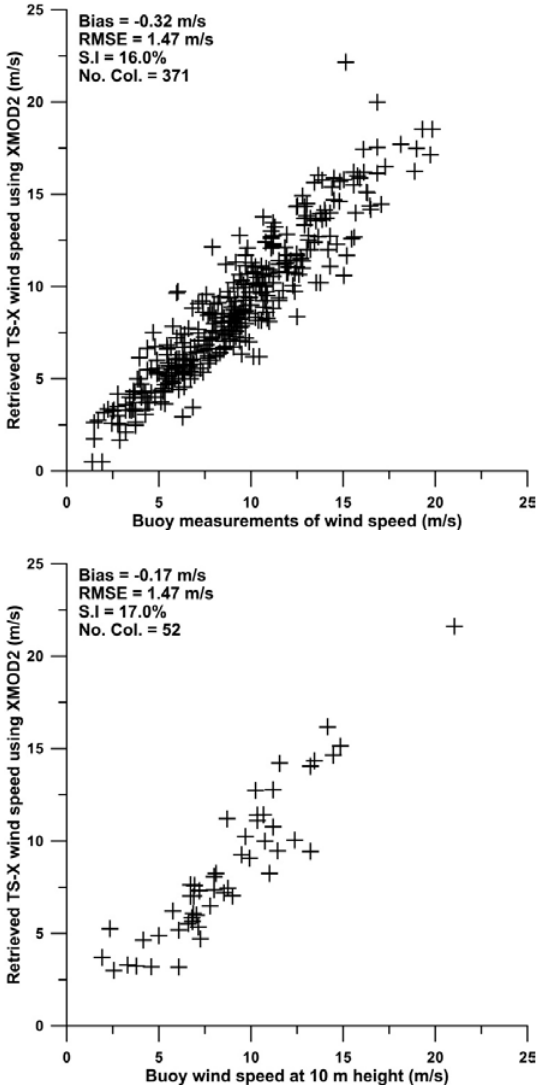
Figure 4: Comparison of the retrieved TS-X/TD-X sea surface wind speed using XMOD2 against in situ buoy measurements (Top: Tuning data set, Bottom: Validation data set) - after Li,